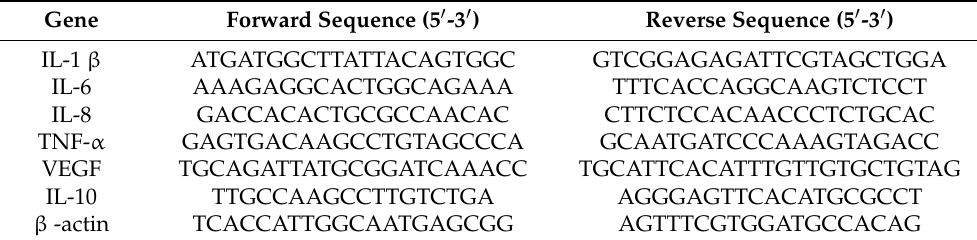
Table 1. Primer sequences used for quantitative real-time